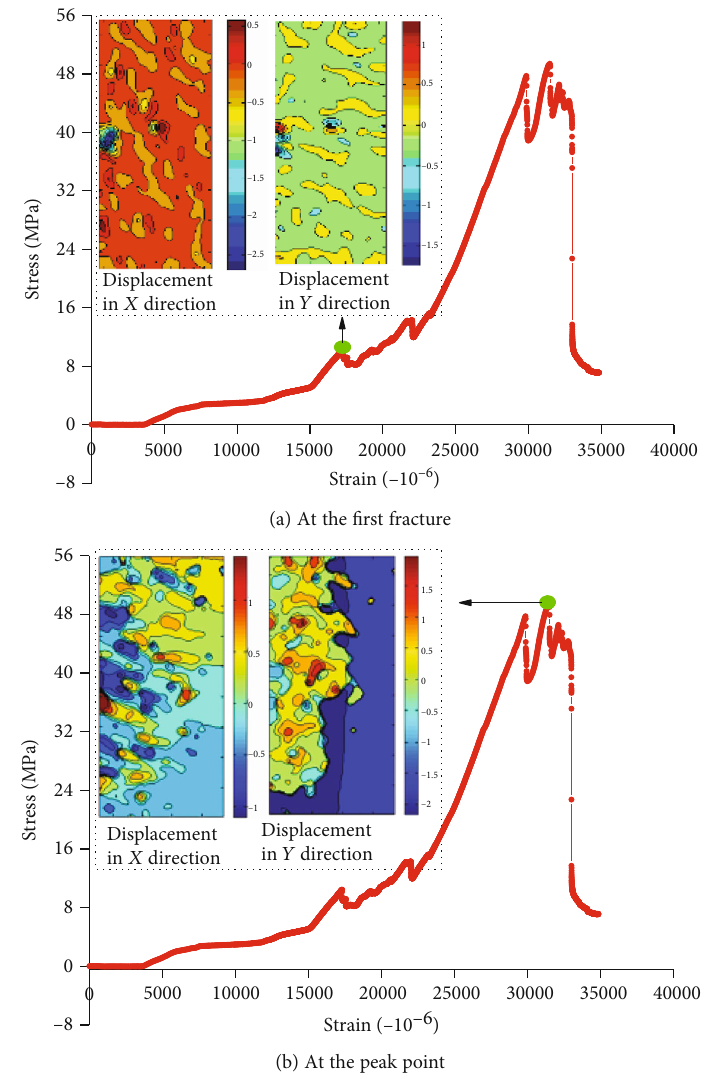
Figure 8: Displacement of specimen S2-3 by